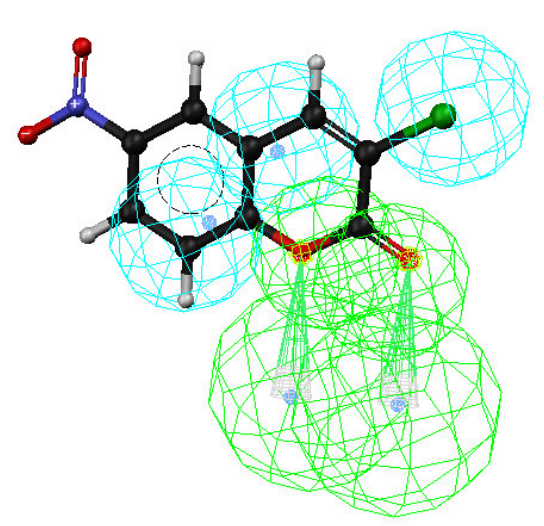
Figure 1: Active molecule 64 fitted to the pharmacophore model